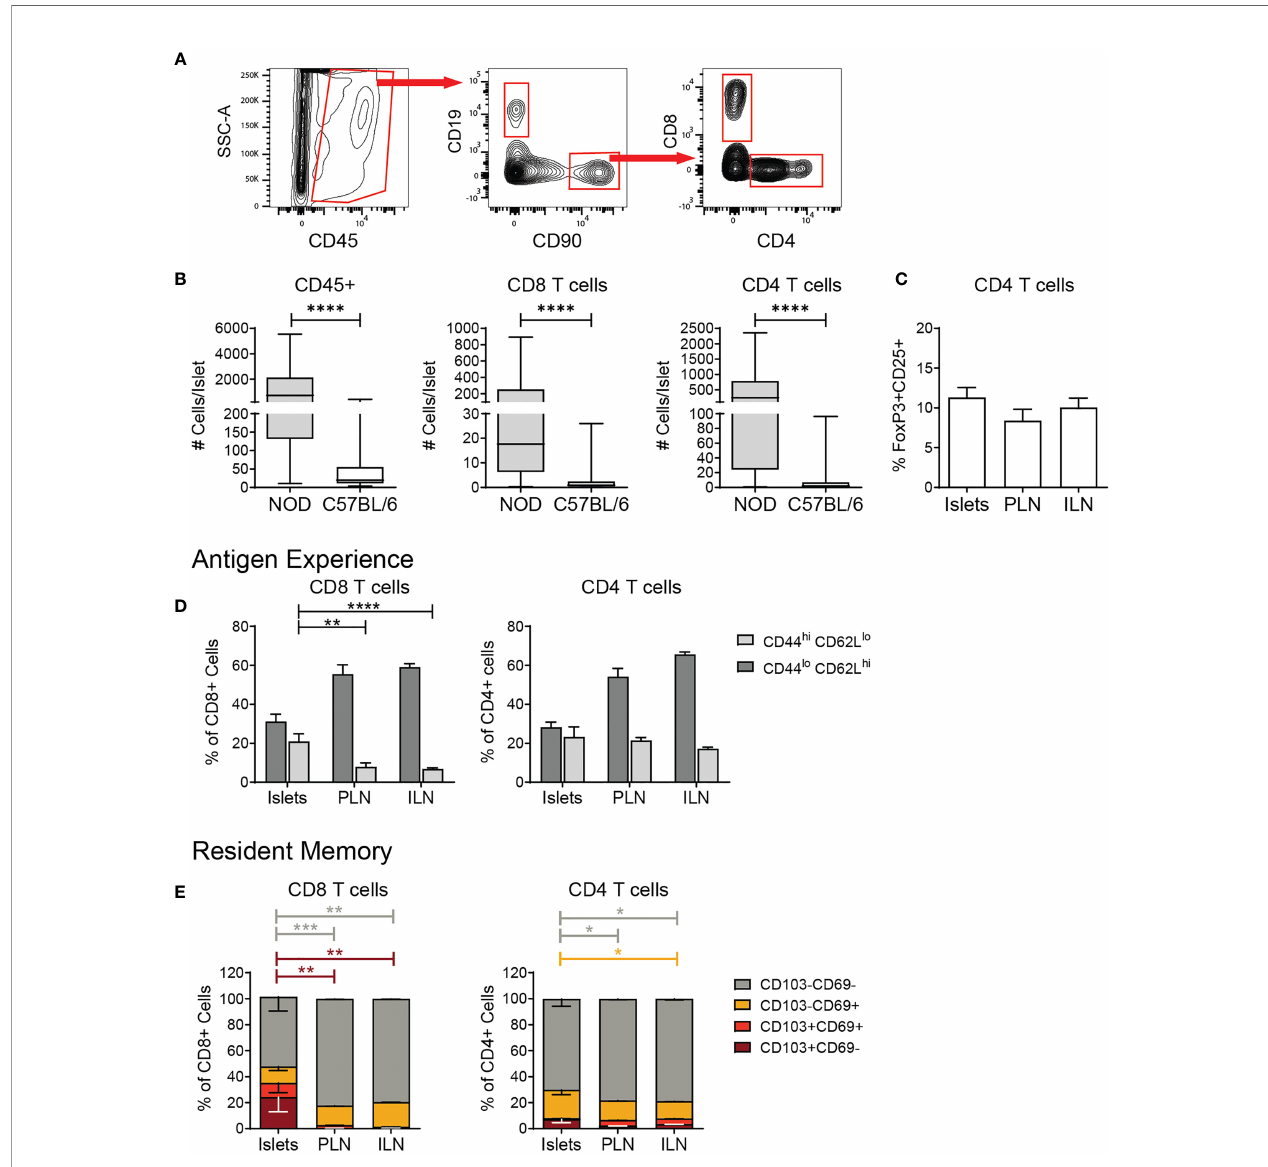
FIGURE 2 | Islet T cells are comprised of naïve, activated, and resident memory CD4 and CD8 T cells. Flow cytometry analysis of T cells in islets and lymph nodes. (A) Example gating scheme of islet lymphocytes. (B) Number CD45+ cells, CD8+ T cells, and CD4+ T cells per islet. n=49-57 C57BL/6 mice from 8- 10 independent experiments, n=6 NOD mice from 5 independent experiments. (C) Percent FoxP3+CD25+ cells of CD4+ T cells. n=9 C57BL/6 mice from 3 independent experiments. (D) Quanti fi cation of CD44 expression in T cells. (E) Percent CD103 and/or CD69 expressing T cells. n=8 C57BL/6 mice from 2 independent experiments. (A – E) Statistics: *p < 0.05, **p < 0.01, ***p < 0.001, ****p < 0.0001. Error bars: SEM. (B) Mann Whitney two-tailed test. (C) One way ANOVA with Tukey ’ s multiple comparisons test. (D, E) Two-way ANOVA with Tukey ’ s multiple comparisons